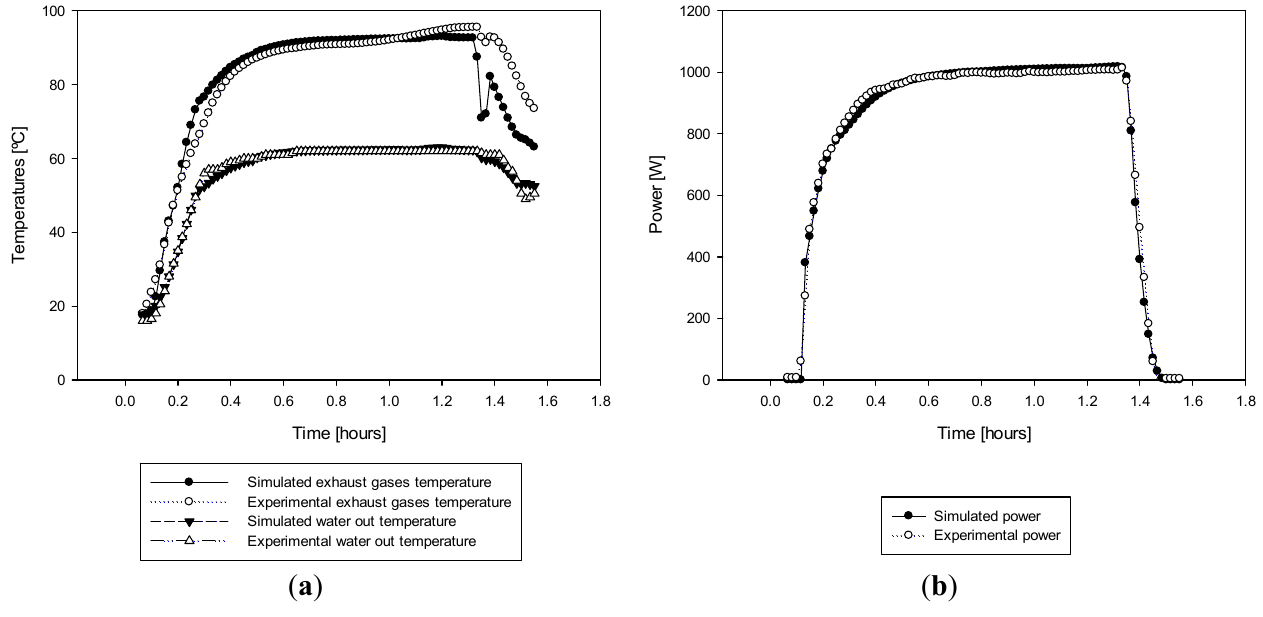
Figure 9. ( a ) Simulated and experimental outlet water temperature and exhaust gases temperature for T = 45 °C; ( b ) Simulated and experimental power for T set